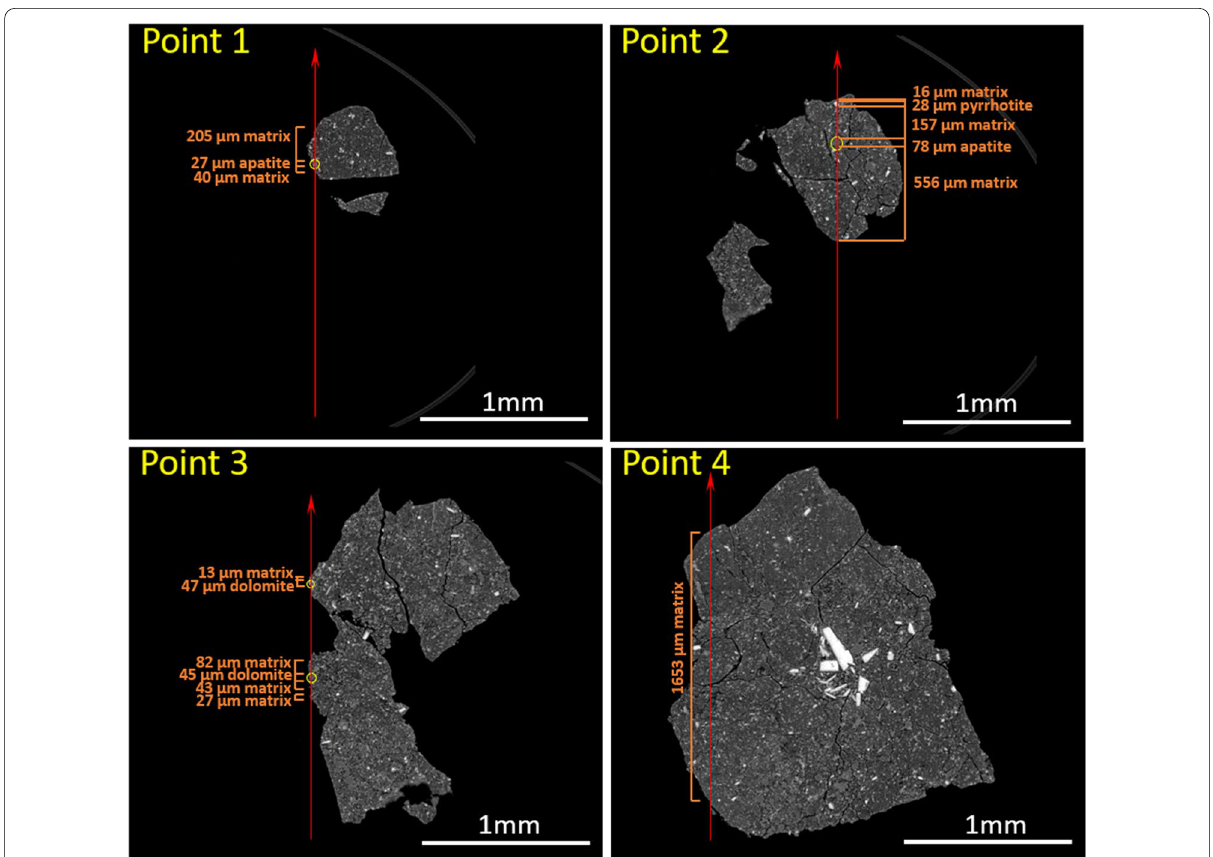
Fig. 5 CT slices that were obtained at SPring‑8 beamline 20XU (Nakamura et al. 2022b) show the positions of the points of interest indicated in Fig. 2A. A red arrow marks the primary X‑ray beam path and direction, fluorescence detector was positioned at the left of the CT image. Yellow circles indicate the Ca‑rich grains (points 1–3) from which REE information is primarily obtained. Point 4 is a matrix measurement and as such has no distinct Ca‑rich grains. Separate grains along the beam path are indicated by their respective size along the beam path in orange, along with an estimate of the mineralogical phase for the larger